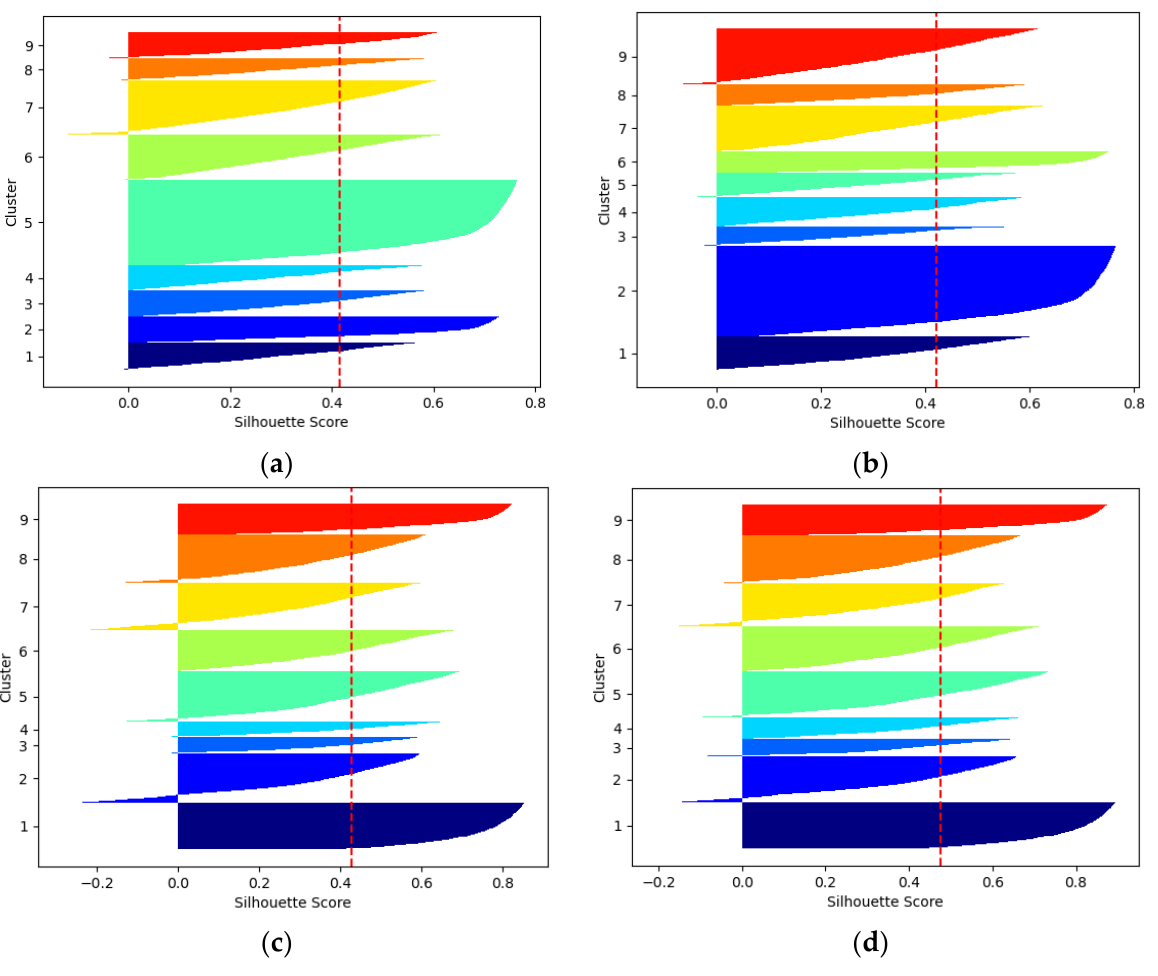
Figure 13. The contour silhouette image of clustering algorithm. ( a ) K-means algorithm with Euclidean distance; ( b ) K-means++ algorithm with Euclidean distance; ( c ) K-means algorithm with IoU; ( d ) K-means++ algorithm with IoU. Table 5. Comparison of clustering